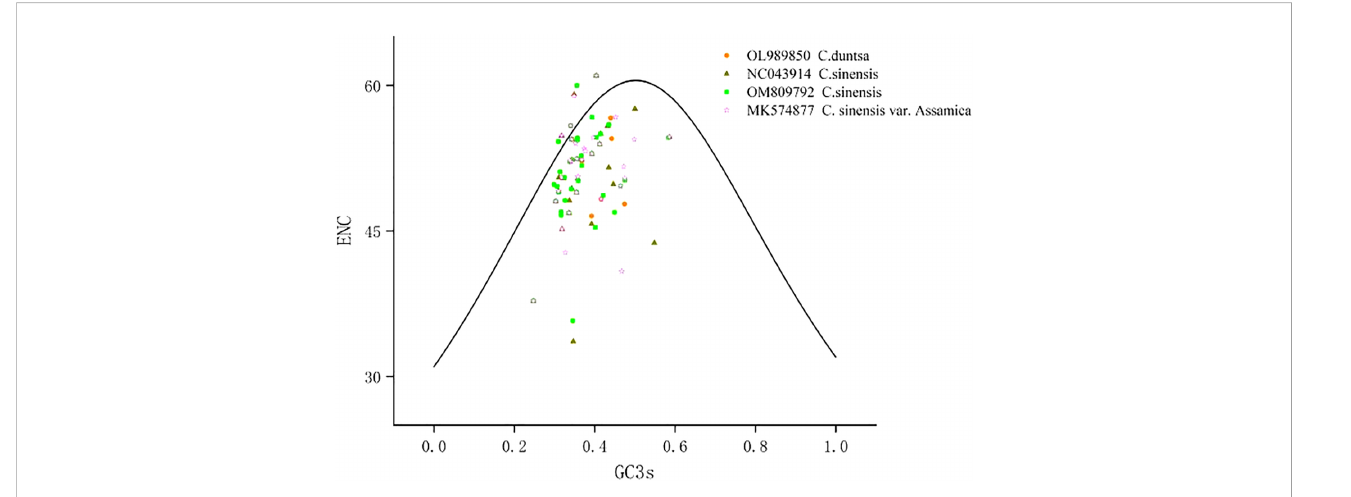
FIGURE 3 ENC plot of four Theaceae mitochondrial genomes.Standard curve line is calculated as follows: ENC = 2 + GC3 + 29/(GC3 2 + (1-GC3) 2